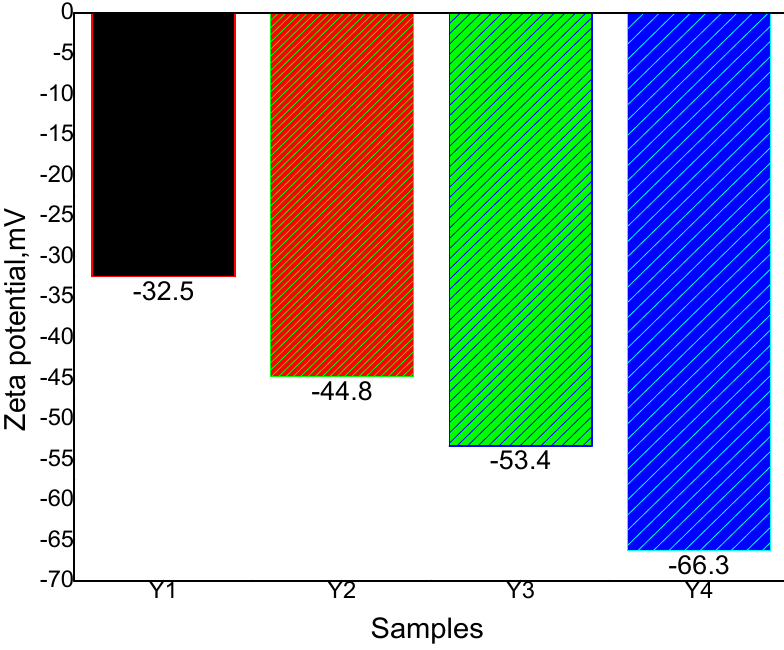
Figure 6. Zeta potential of rGO-CuO (Y1,Y2,Y3 and Y4) nanoparticles.